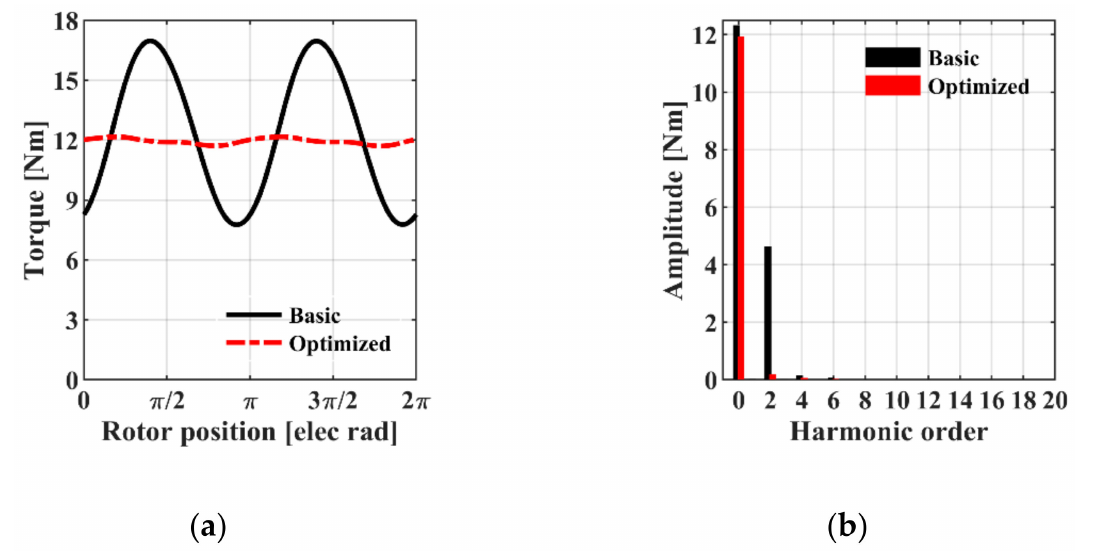
Figure 14. Comparison between the basic and optimized APMMs with 20 stator segments at rated current. ( a ) Torque waveforms. ( b ) Torque harmonic